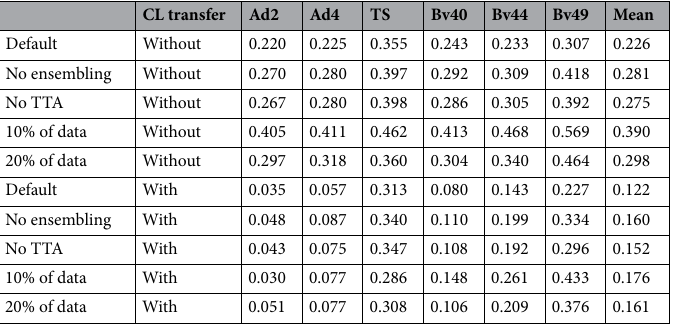
Table 1. Standard deviation of the raw prediction change for all individual variations (abbreviations as in Fig. 3) compared to the default. “Centerline (CL) Transfer” refers to the centerlines being propagated from the default to the varied configurations.